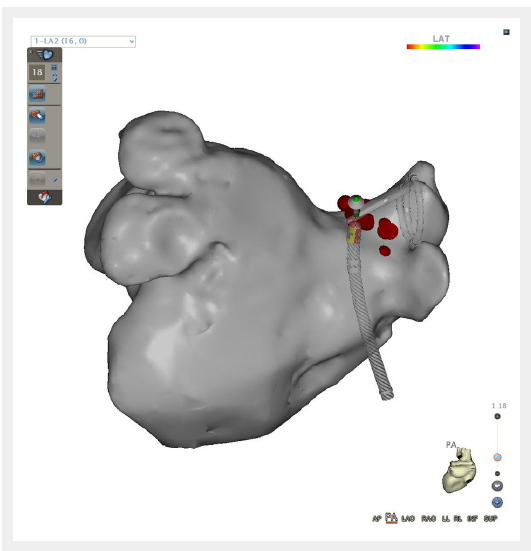
The aim of catheter ablation of atrial fibrillation is to electrically isolate the pulmonary veins. The 3D reconstruction of the left atrium with two right-sided and two left-sided pulmonary veins is shown in grey (posterior view). The 3D map of the left atrium is constructed at the beginning of the procedure to guide ablation, increase accuracy and decrease radiation exposure. In the featured case, radiofrequency ablation was started at the right superior pulmonary vein. The circular catheter within the right superior pulmonary vein is used to guide ablation and confirm isolation of the pulmonary vein at the end of the procedure. The ablation catheter is shown in a shaded grey with a red and yellow tip. The ablation points are shown in